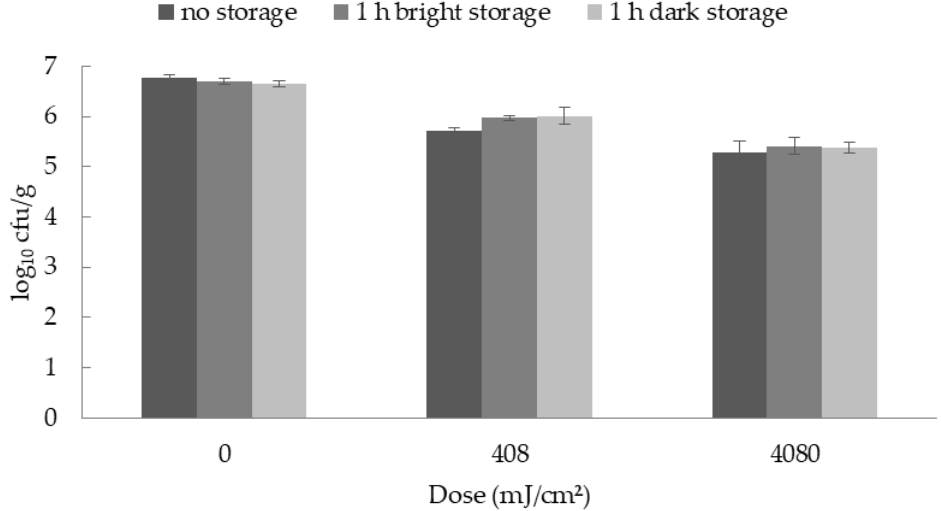
Figure 3. Mean and standard error values of the bacterial counts of Brochothrix thermosphacta inoculated on ham immediately after UV-C treatment and after 1 h of light or dark storage ( n = 3). Since no statistically significant differences occurred, no letters are given.